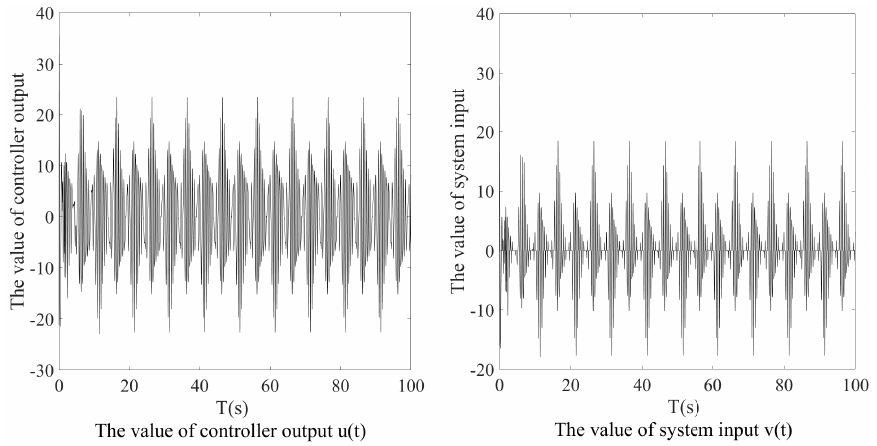
Figure 3. Controller output curve and system input curve in known time-varying delay form (with dead-zone compensation